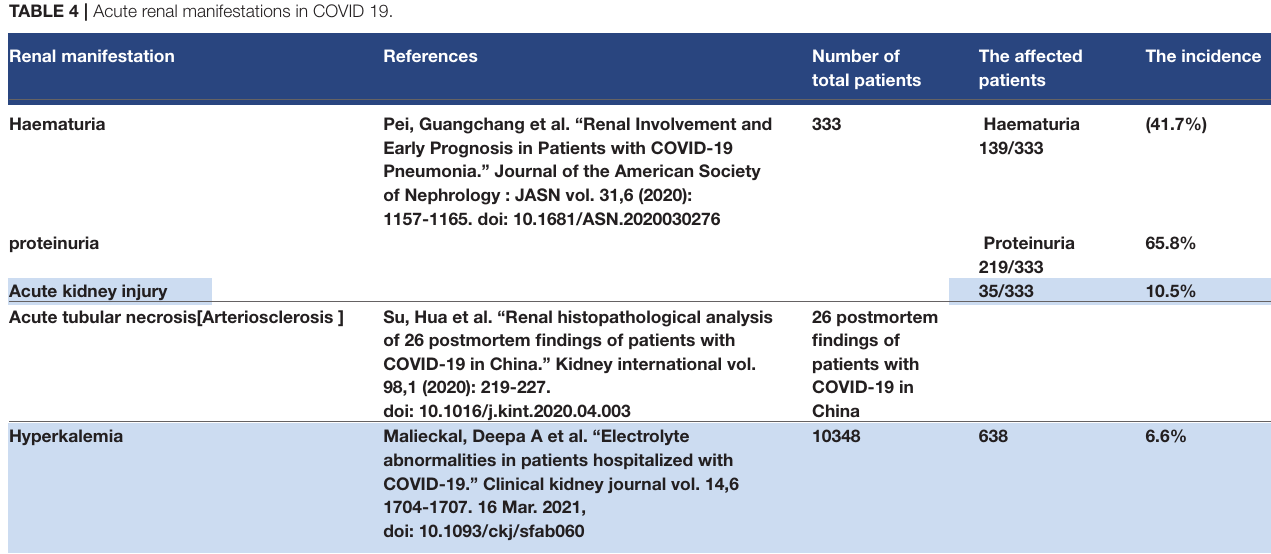
TABLE 4 | Acute renal manifestations in COVID